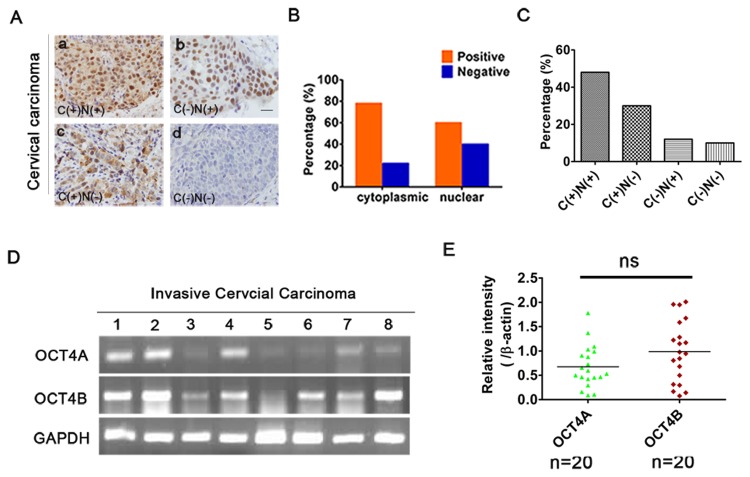
Identification of OCT4 isoforms in human cervical cancer.(A), OCT4 expression status in 50 cervical cancer patients was divided into four groups based on staining patterns and subcellular localization: cytoplasmic and nuclear (C+/N+); cytoplasm (C+/N-); nuclear positive (C-/N+); and complete loss of staining (C-/N-). Scale bars, 50 μm. Magnification, ×100. (B), The positive percentage of cytoplasmic and nuclear staining of OCT4. (C), The positive rates of (A). (D), RT-PCR analysis of OCT4A and OCT4B mRNA levels in 20 CC. (E), Scatter plot showing the relative mRNA levels of OCT4A and OCT4B. (t-test, P > 0.05). Data shown were the mean ± SD. ns: no significance.